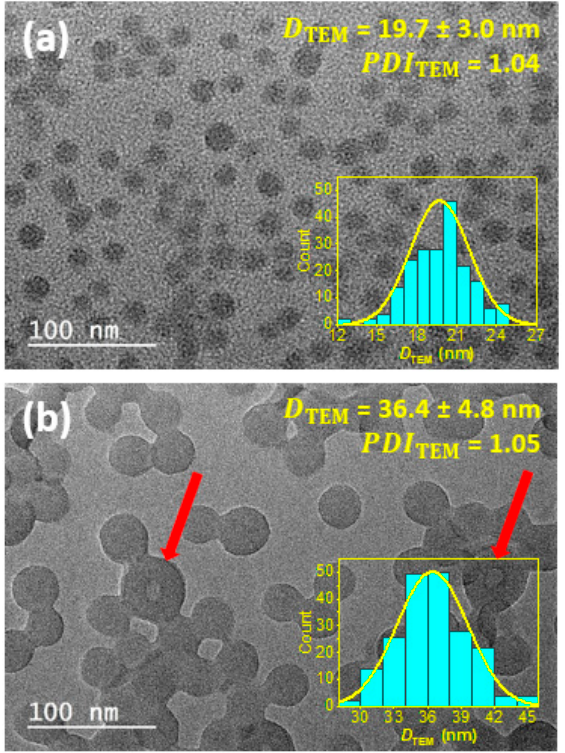
Figure 2. Conventional TEM images of ( a ) PHEA 85 – b –PS 130 and ( b ) PHEA 23 – b –PS 130 block copolymer nanoparticles. The inset shows the size distribution obtained from TEM measurements. The red arrows in ( b) highlight vesicular structures.